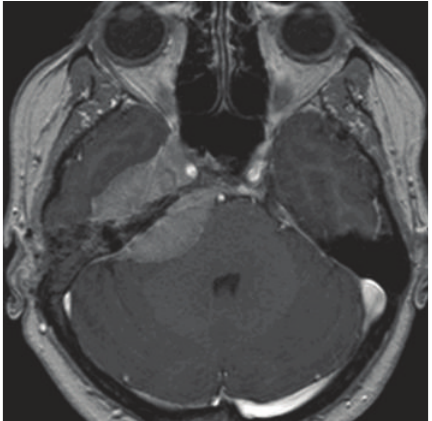
Figure 1: Axial high-resolution CT scan showing a right tympa- nomastoid homogenous opacity and petrous bone remodeling.